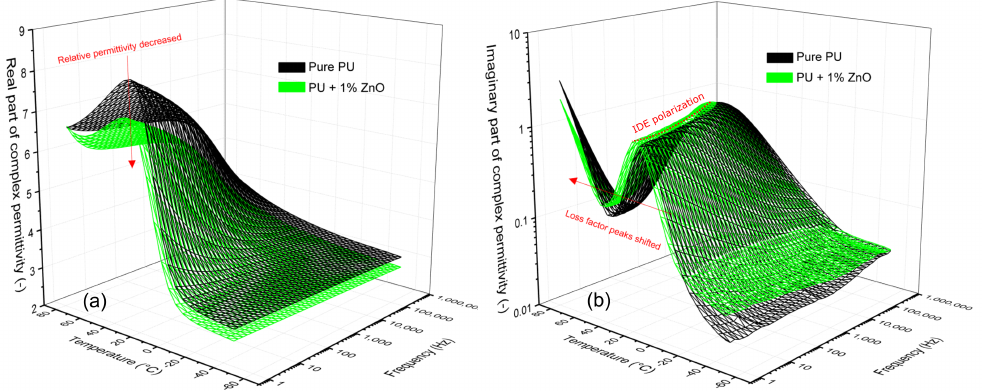
Figure 5. The real ( a ) and imaginary ( b ) part of complex permittivity versus frequency and temperature for the pure PU resin and its mixture with 1.0 wt.%